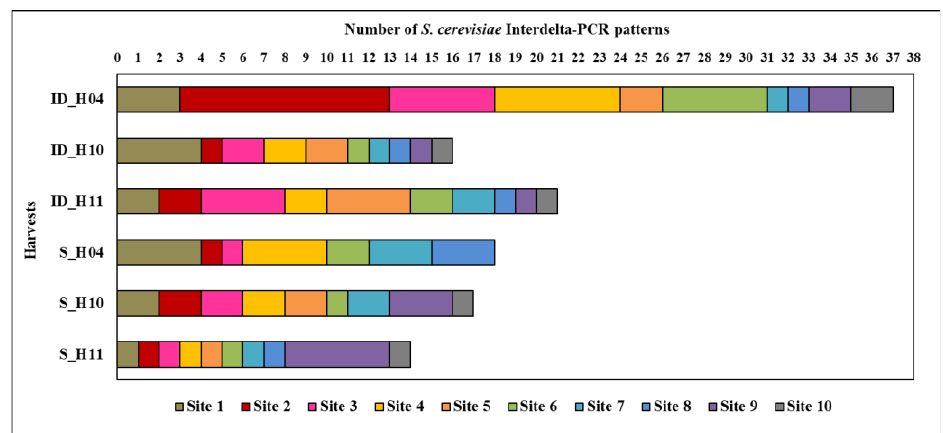
Figure 1. Number of Saccharomyces cerevisiae Interdelta-PCR patterns by vineyard, harvest, and sampling site. ID: EEA Mendoza INTA Vineyard; S: winery vineyard; H: harvest; H04: 2004th harvest; H10: 2010th harvest; H11: 2011th harvest.